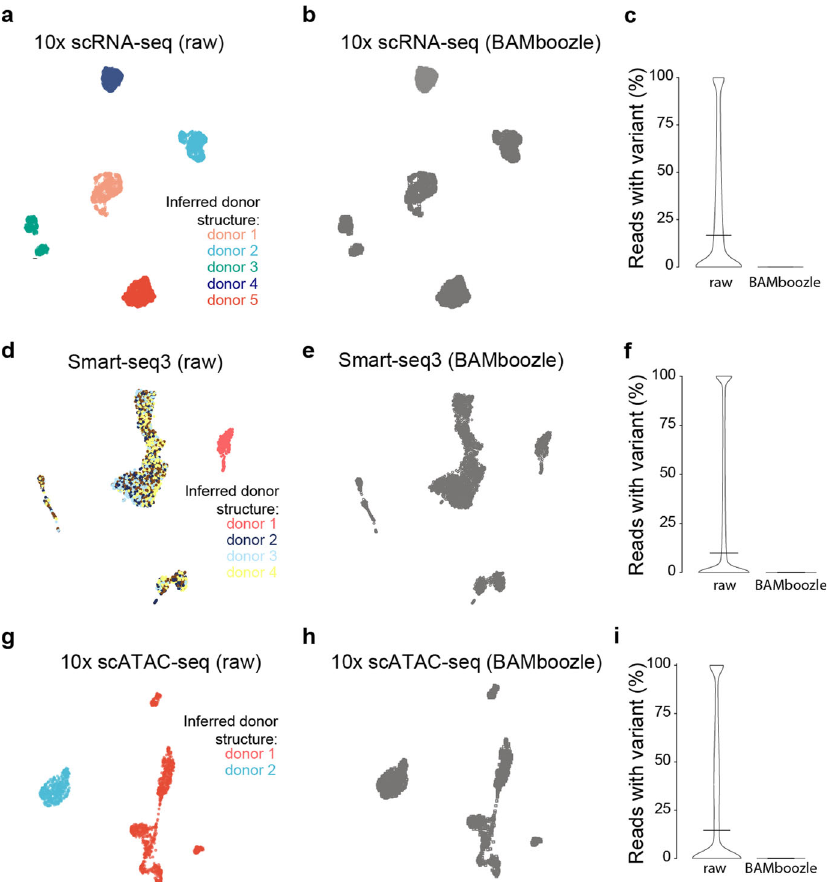
Fig. 2 Processing of human scRNA-seq and scATAC-seq data with BAMboozle. a , b Uniform Manifold Approximation and Projection (UMAP) plot of scRNA-seq data (10× Genomics) from fi ve different cell lines (H2228, H1975, A549, H838 and HCC827; in total 2937 cells), colored according to donor identity inferred from the a raw and b processed sequencing data. c Percentage of 10× Genomics scRNA-seq reads containing alternate allele information at interrogated variant positions, for raw and processed data, respectively. All cells were combined and variants with suf fi cient coverage ( n = 75,461) were used. d , e UMAP plot of scRNA-seq data (Smart-seq3) generated from PBMCs (4 donors) and HEK293T cells (in total 3129 cells), colored according to donor identity inferred from the d raw and e processed sequencing data. f Percentage of Smart-seq3 scRNA-seq reads containing alternate allele information at interrogated variant positions, for raw and processed data, respectively. All cells were combined and variants with suf fi cient coverage ( n = 1,503,063) were used. g , h UMAP plot of scATAC-seq data (10× Genomics) generated from one PBMC donor and GM12787 cells (in total 1497 cells), colored according to donor identity inferred from the d raw and e processed sequencing data. i Percentage of 10× Genomics scATAC-seq reads containing alternate allele information at interrogated variant positions, for raw and processed data, respectively. All cells were combined and variants with suf fi cient coverage ( n = 95,127) were